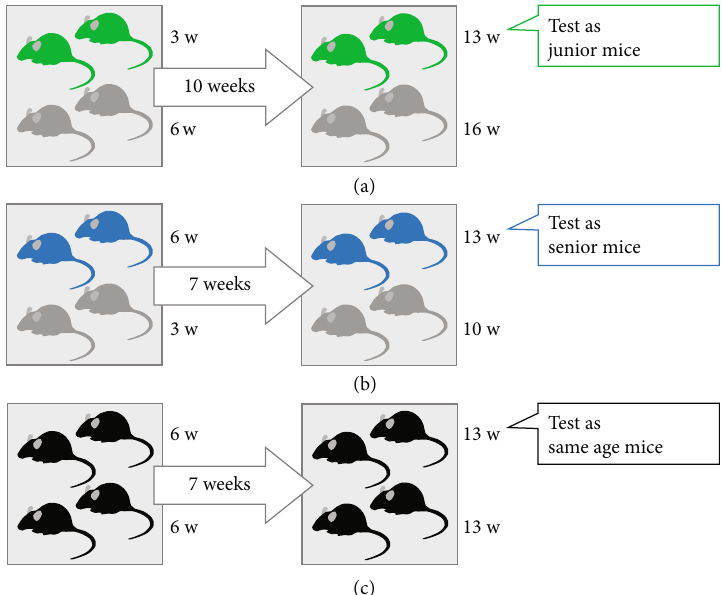
Figure 7: Schematic illustration of the experimental design. (a) Junior mice group: two 3-week-old mice and two 6-week-old mice were housed together in each cage. We housed the 3-week-old mice until they were 13 weeks old. (b) Senior mice group: two 6-week-old mice and two 3-week-old mice were housed together in each cage. We housed the 6-week-old mice until they were 13 weeks old. (c) Same-age mice group: four 6-week-old mice were housed together in each cage. We housed the 6-week-old mice until they were 13 weeks